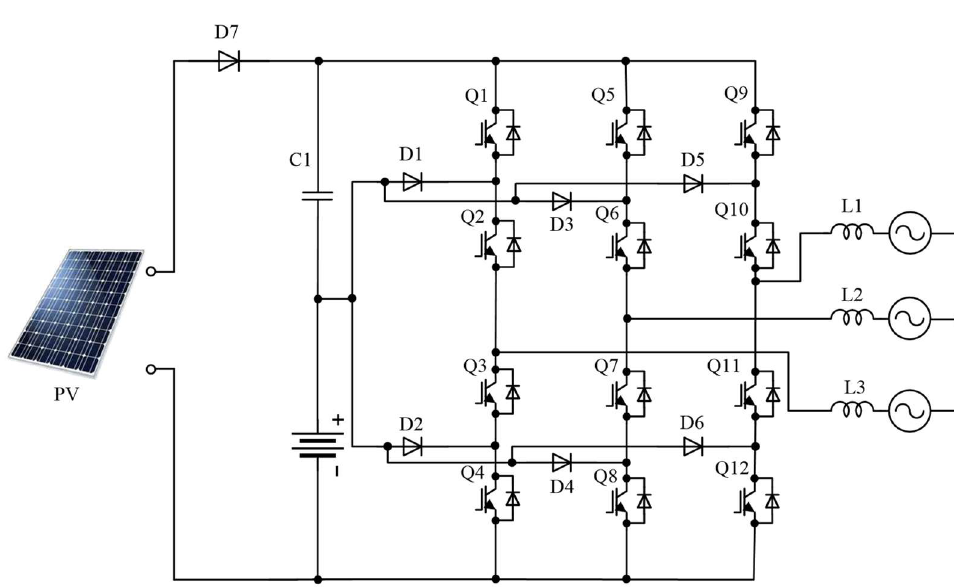
Figure 9. Diode-Clamped Multi-Port Converter [51].